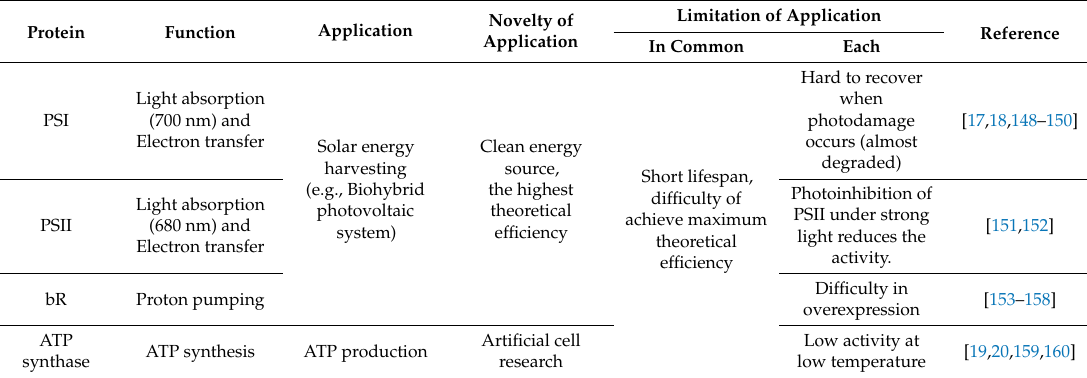
Figure 8. Schematic mechanism of photosynthesis in the thylakoid membrane (ATP production). When light reaches the reaction center of PSI and PSII, the excited electrons from the reaction center are transferred. At this time, a proton gradient is formed across the membrane due to the electron transfer and water splitting, and the proton concentration of the thylakoid lumen increases. Thus, the proton is transferred through ATP synthase from the thylakoid lumen to the stroma. As a result, ATP is synthesized at the stroma in the cell. Table 3. Summary of the characteristics of energy harvesting proteins including their function, application, and the novelty and limitation of